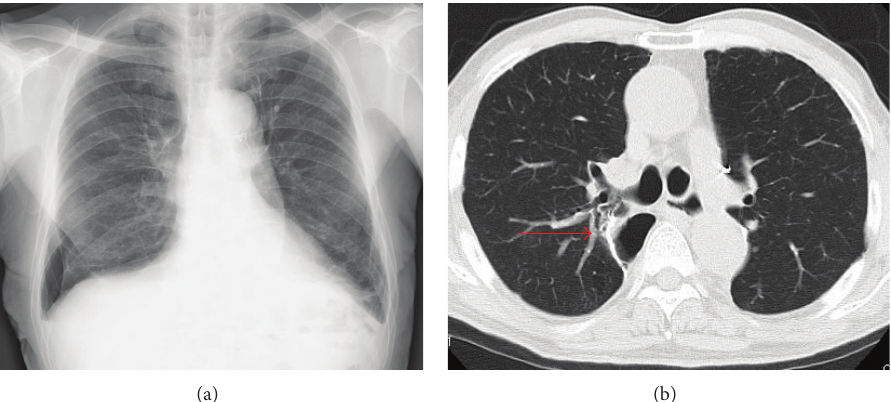
Figure 1: (a) A right pneumothorax is observed in the lower right lung field. (b) The thoracic CT findings suggest that the fistula might exist in the periphery of the B 2 a bronchus (arrow).